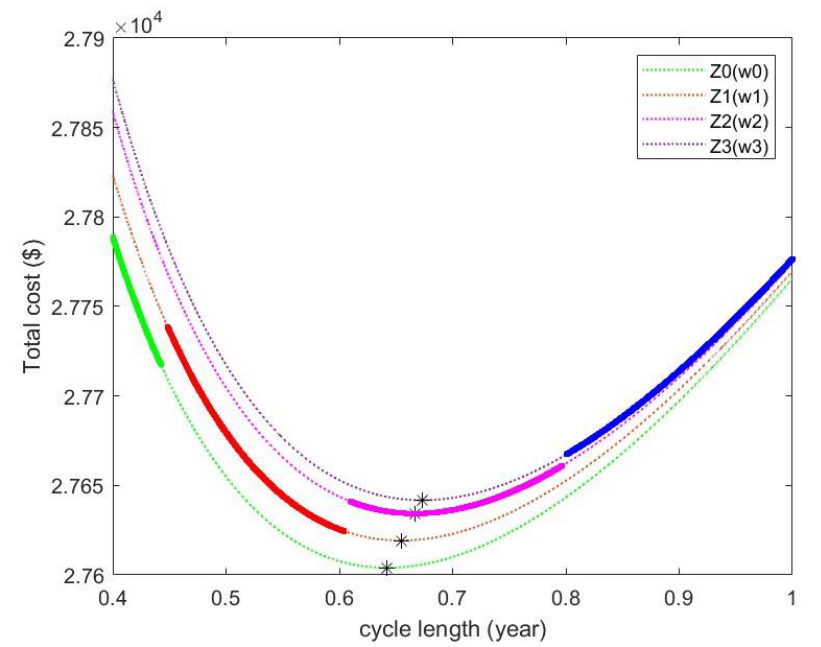
Table 6. Warm-up time diagram based on the downtime range with a rework phase.